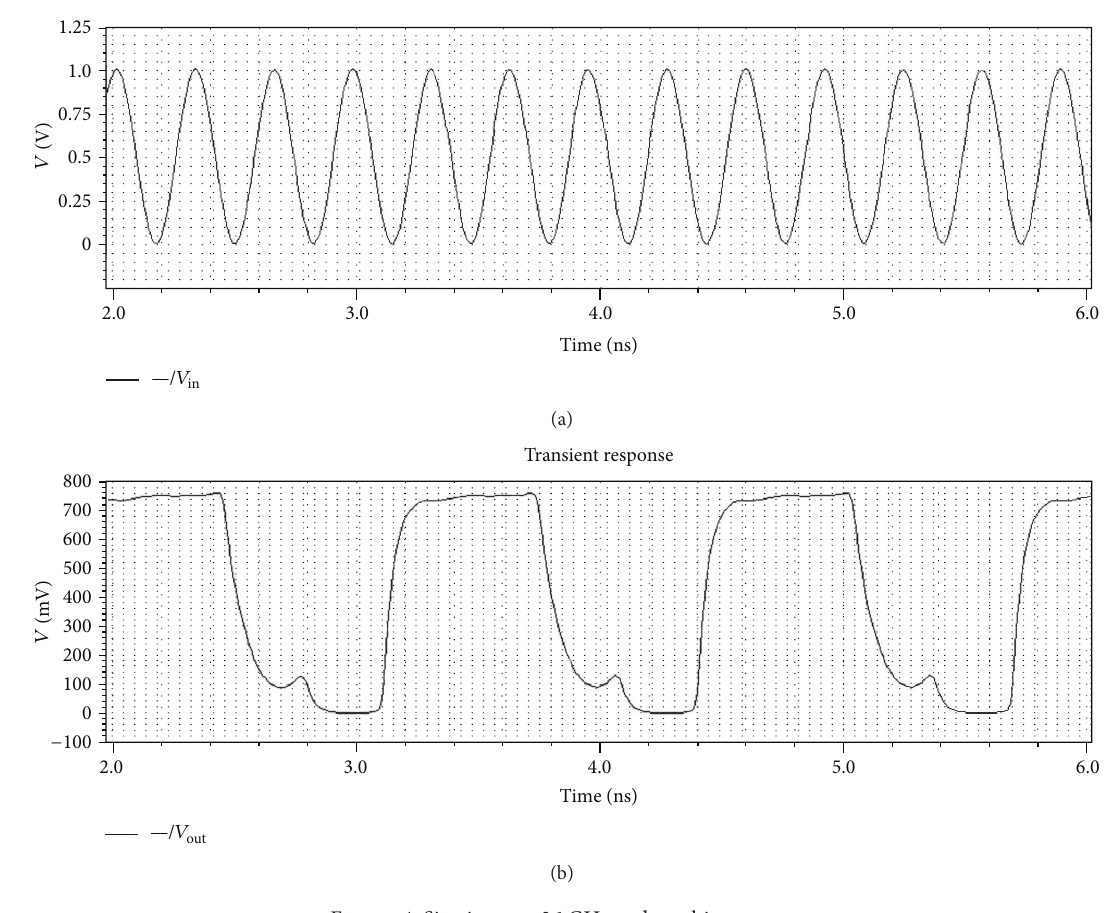
Figure 4: Sine input at 3.1 GHz and resulting output.